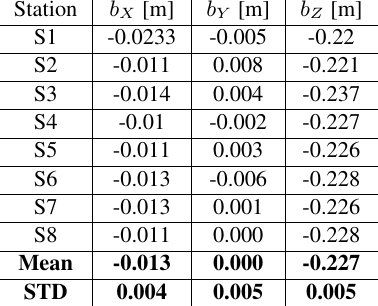
Table 1. Lever-arm adjusted values